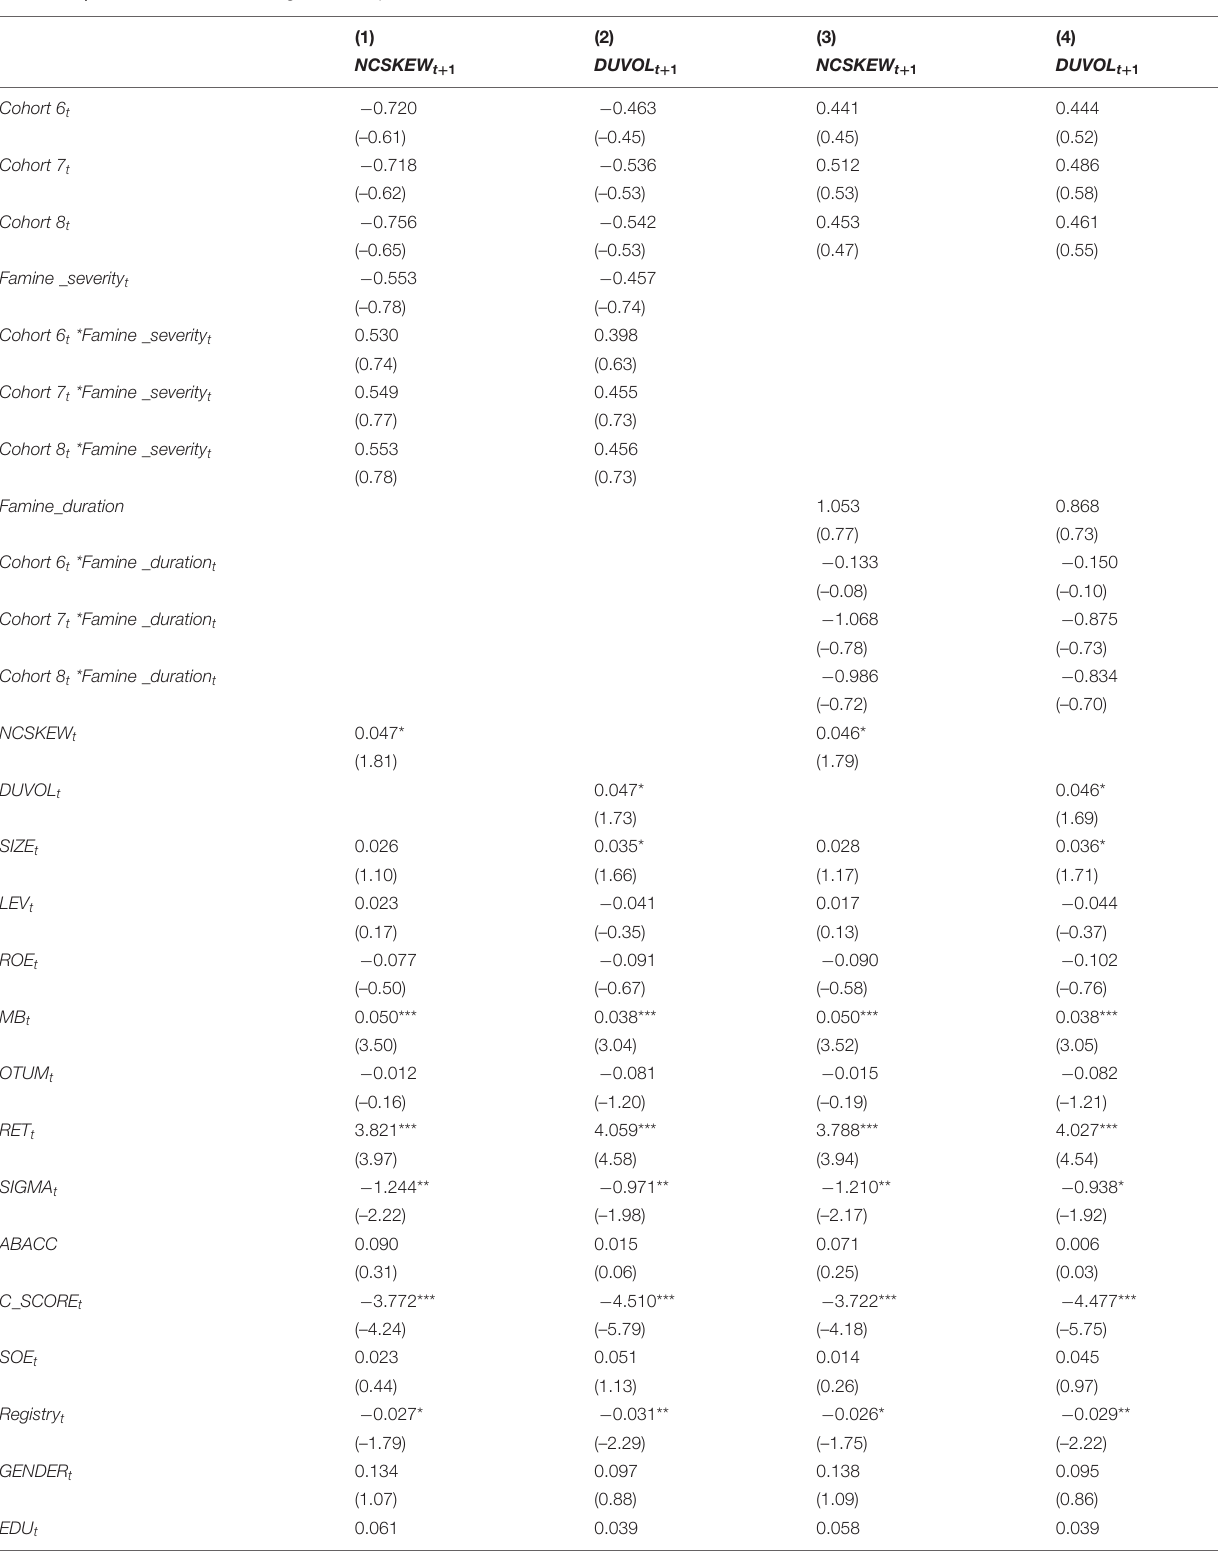
TABLE 11 | Robustness check: Testing the assumption behind the DID